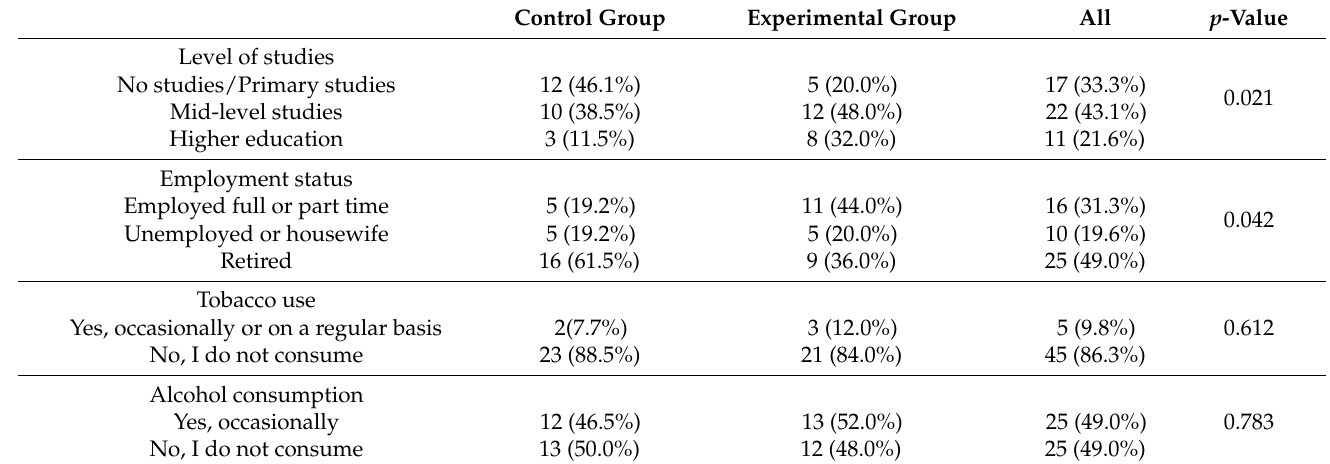
Table 1. Cont. Control Group Experimental Group All